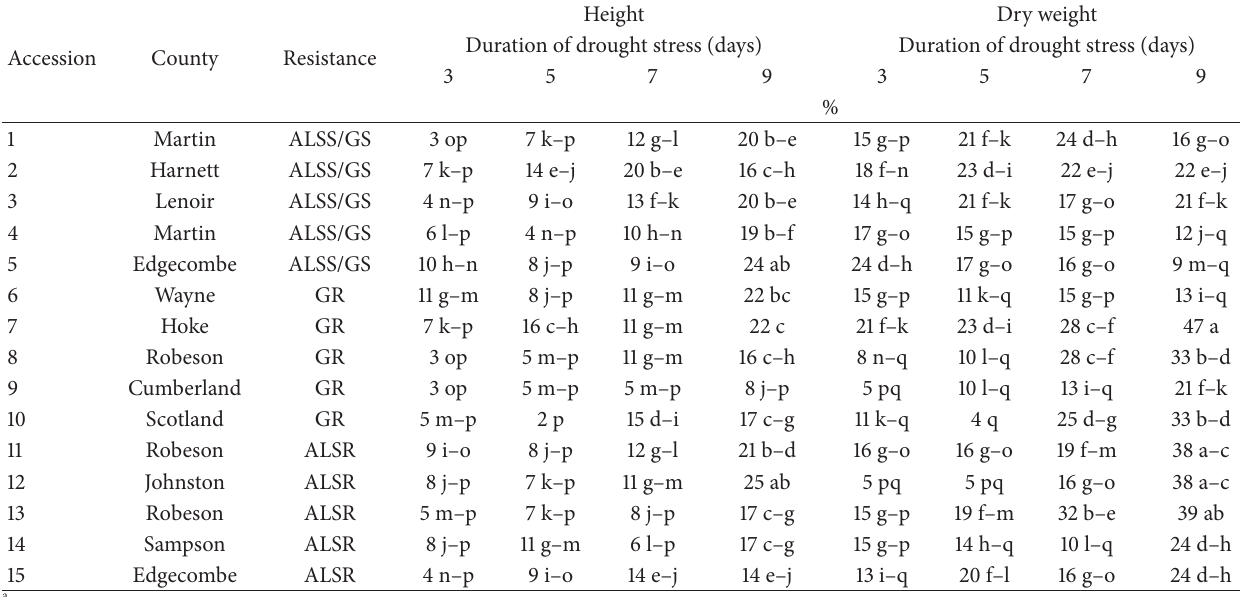
Table 3: Percent reduction in height and dry weight of 15 Palmer amaranth accessions at harvest (30 DAE) as affected by the interaction of accession and duration of drought stress a,b .